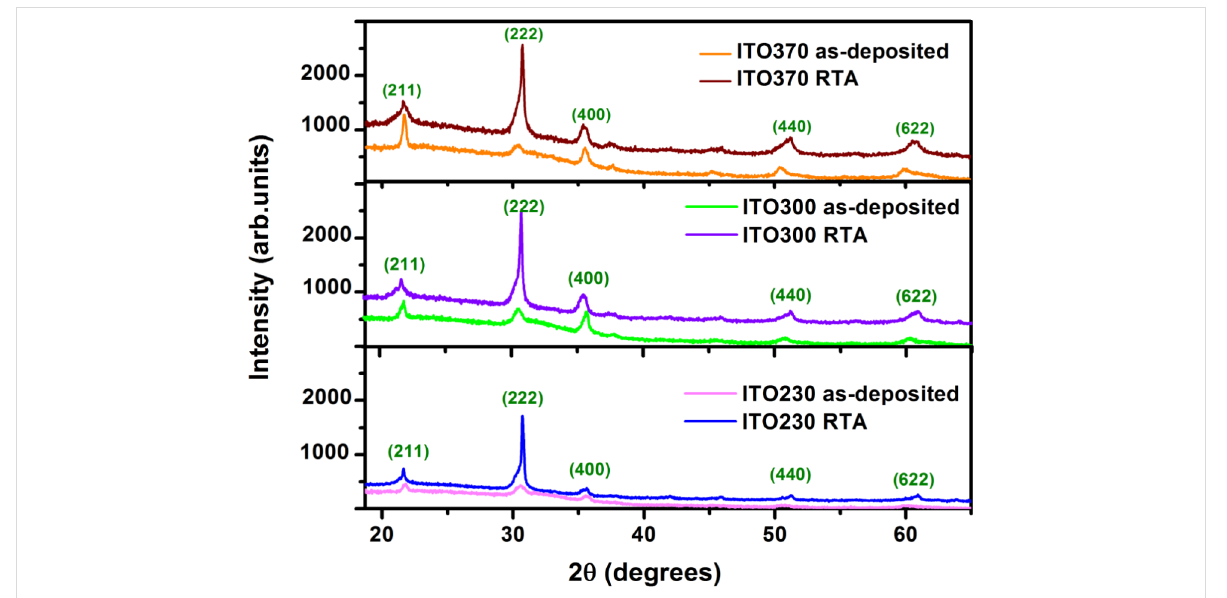
Figure 2: XRD patterns for the as-deposited and RTA-processed ITO